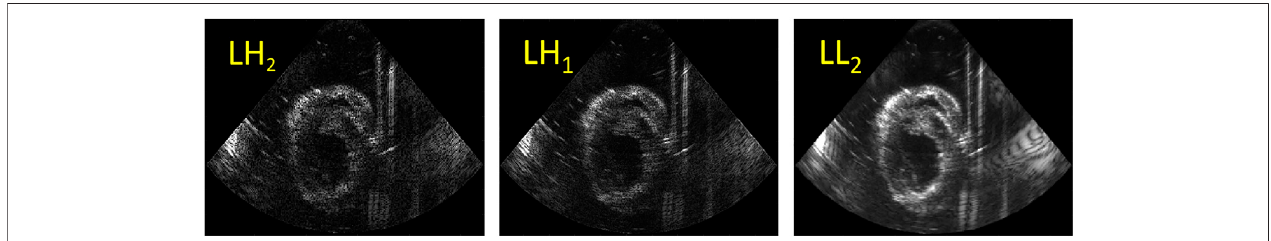
FIGURE 3 | An example of DWT decomposition using 2 layers: the low horizontal and vertical high subbands (LH 2 , LH 1 ) ( left two images ); the low frequency subband LL 2 ( right ).